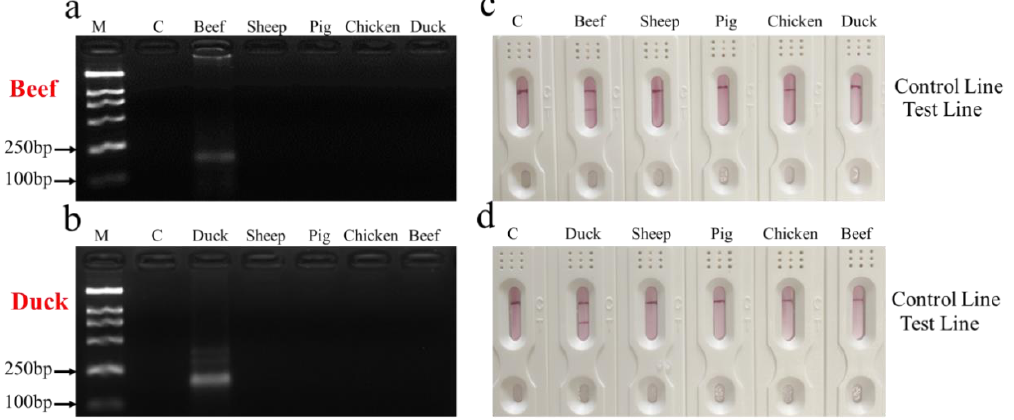
Figure 2. Specificity analysis of beef ( a , b ) duck by RPA with agarose gel electrophoresis. Lane M: DL2000 Marker, Lane C: blank; specificity analysis of beef ( c , d ) duck by RPA with lateral flow biosensor. Lane C: